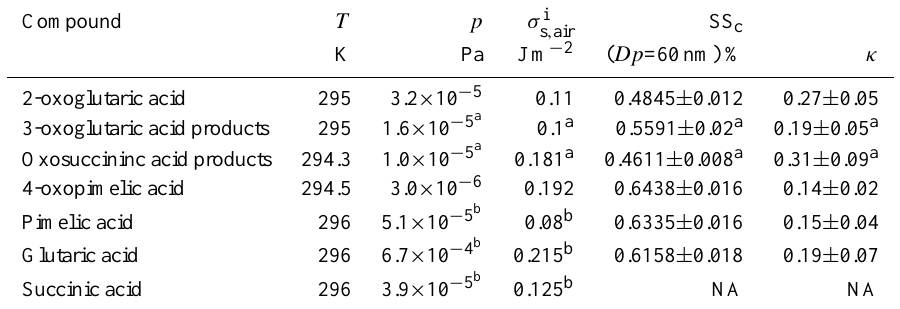
Table 4. Properties derived from evaporation analysis and K¨ohler theory: vapor pressures ( p ) and surface free energies ( σ i temperature T , critical supersaturation SS c for a dry particle with a diameter of 60nm, and the single hygroscopicity parameter, κ , averaged for all